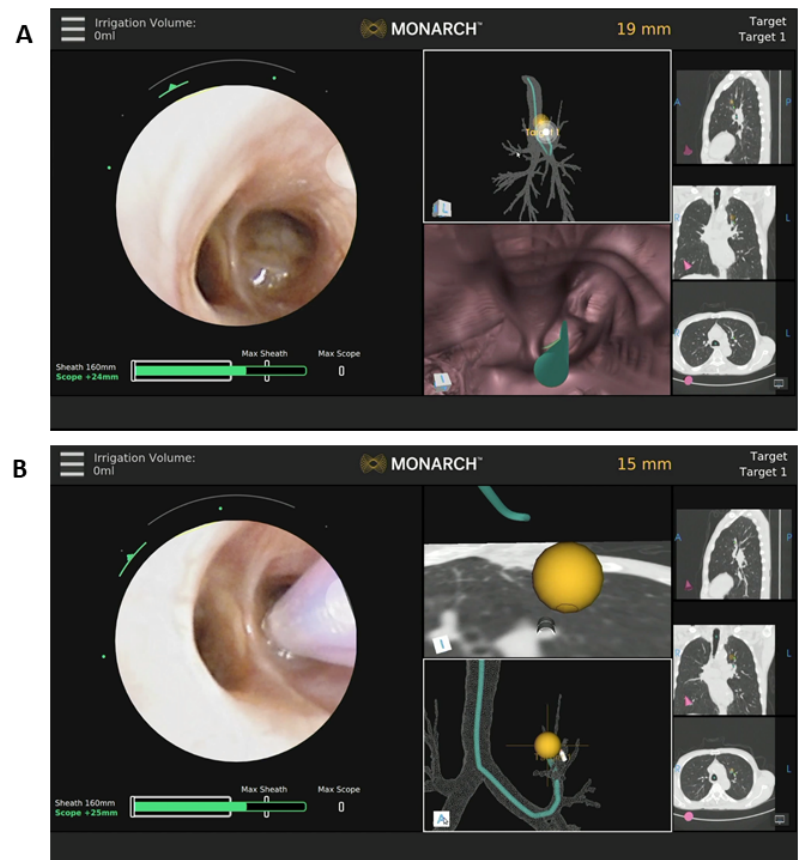
Figure 1. Example of images from the monitor during a robotic bronchoscopy procedure. ( A ) The left part of the screen shows the bronchoscopic image of the left upper lobe sub-segmental bronchus with endobronchial tumor. The middle images show the generated pathway to the left upper lobe nodule and the right images show the accommodating sagittal, coronal and axial views of the tumor in the left upper lobe. ( B ) Needle biopsy of the tumor shown in ( A ).